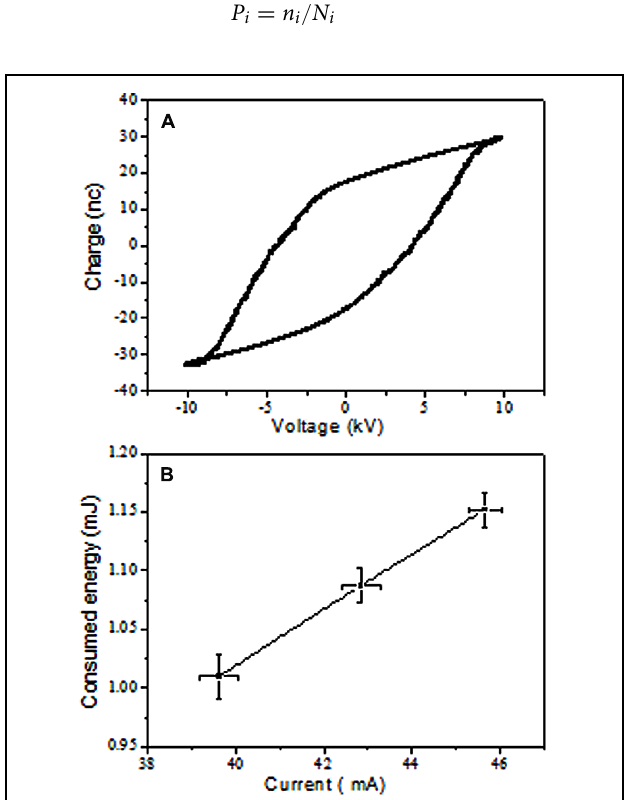
FIGURE 3 | Emission spectra of atmospheric pressure DBD plasma at 70 mA peak to peak current in the range of 200 to 850 nm. (A) Spectra were normalized to the highest peak of the N 2 second positive system 0–0 transition (337.2 nm). (B) Represents magnified scale to show the existence of nitric oxide (NO)